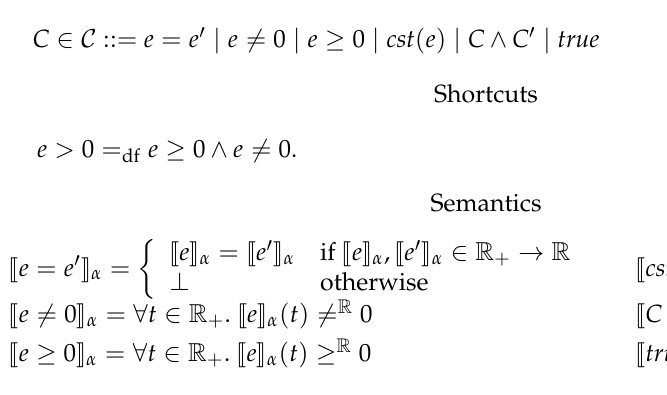
Figure 12. Constraints on kinetic